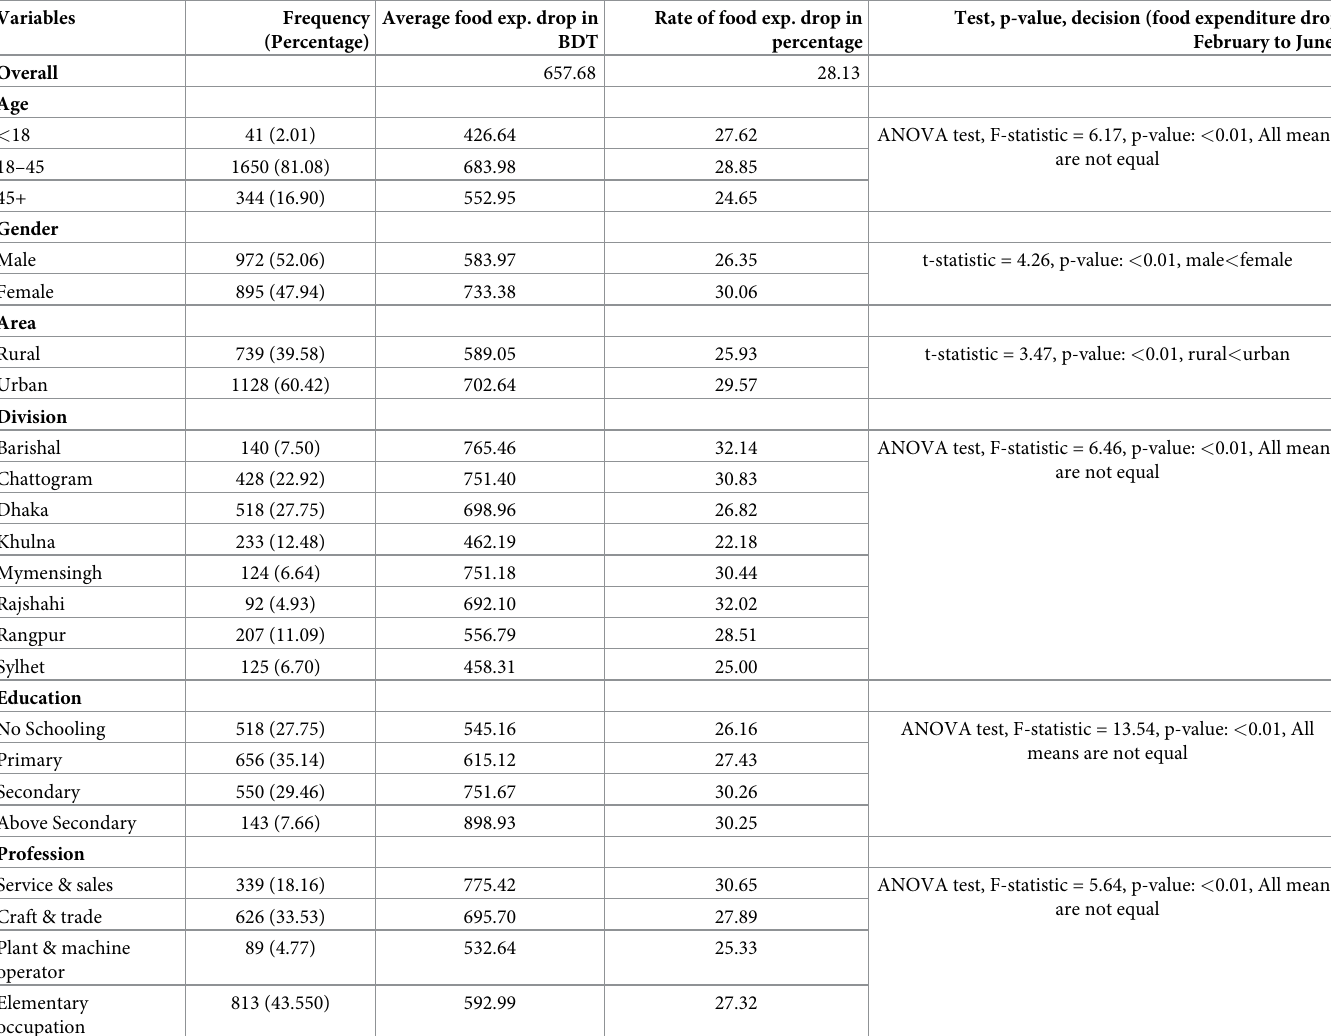
Table 2. Distribution and association of socio-economic characteristics and food expenditure downfall.